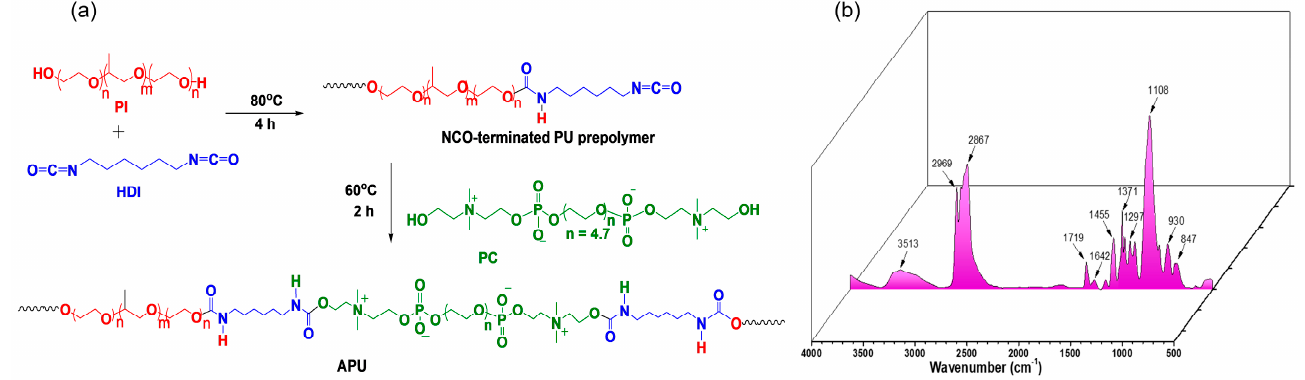
Figure 1. ( a ) Synthesis route and ( b ) IR spectrum of APU.